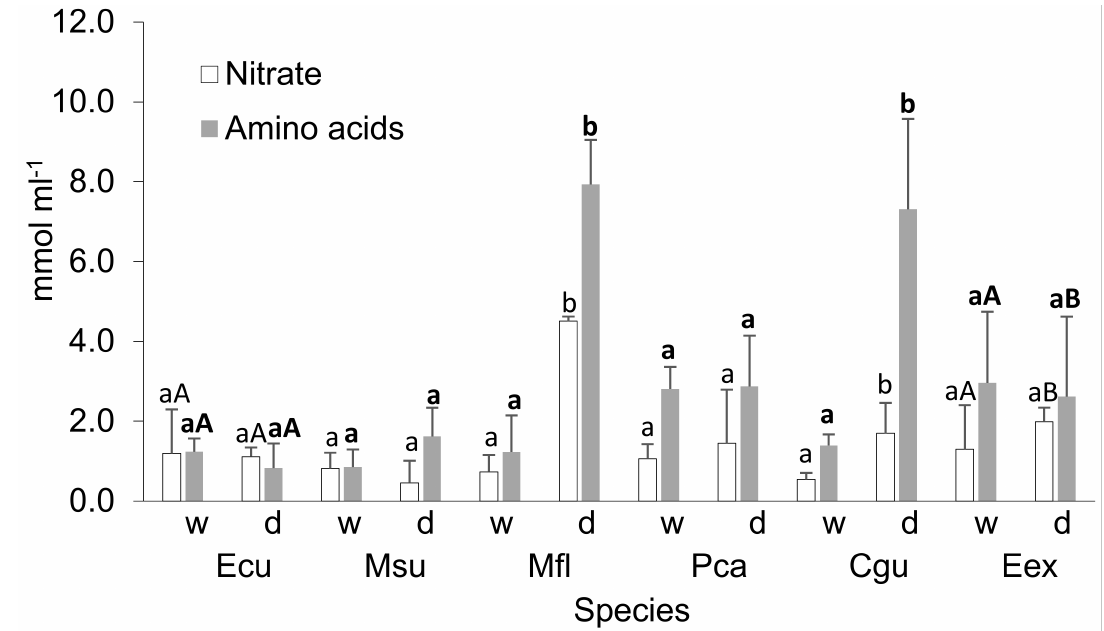
Figure 1. The concentrations of NO 3 − and free amino acids in the xylem sap of Myrtaceae species for ombrophyllous dense forest and semideciduous forest. Data are the mean ± standard error; different lowercase letters indicate significant differences between seasons by species, and different uppercase letters indicate significant differences between species within the same Myrtaceae genus (ANOVA and Tukey’s HSD post hoc test, α = 0.05). Ecu = Eugenia cuprea , Msu = Marlierea suaveolens